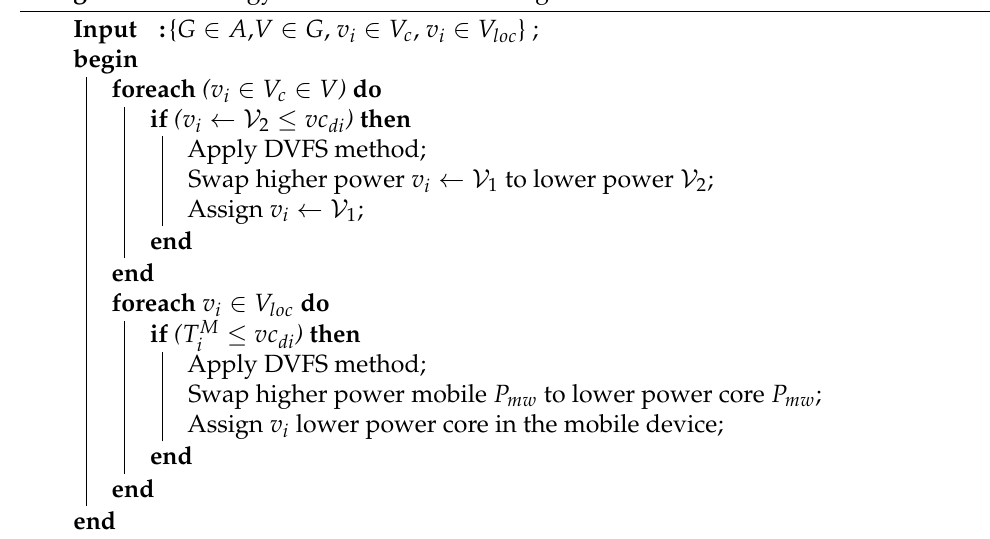
Algorithm 4: Energy-efficient task